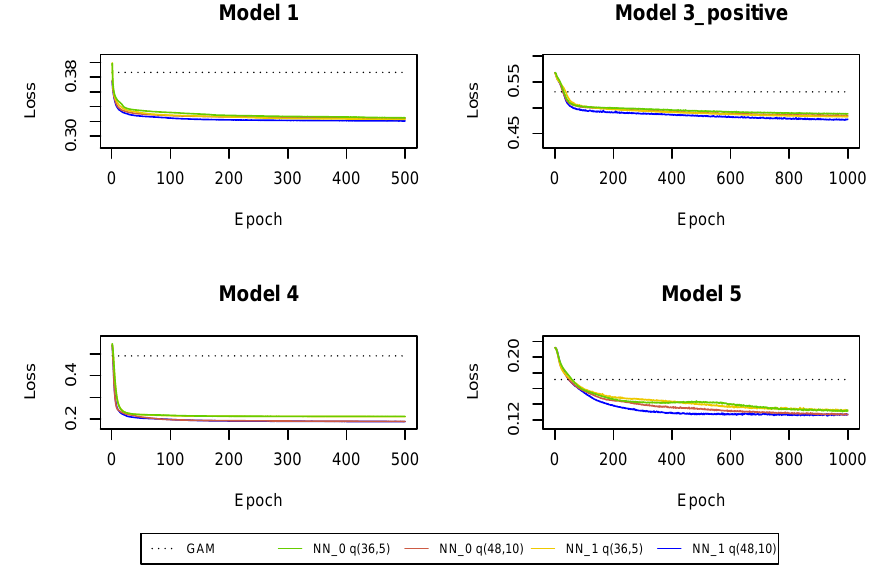
Figure A3. Cross-entropy and deviance loss functions on validation sets observed during the training of the neural networks in k =